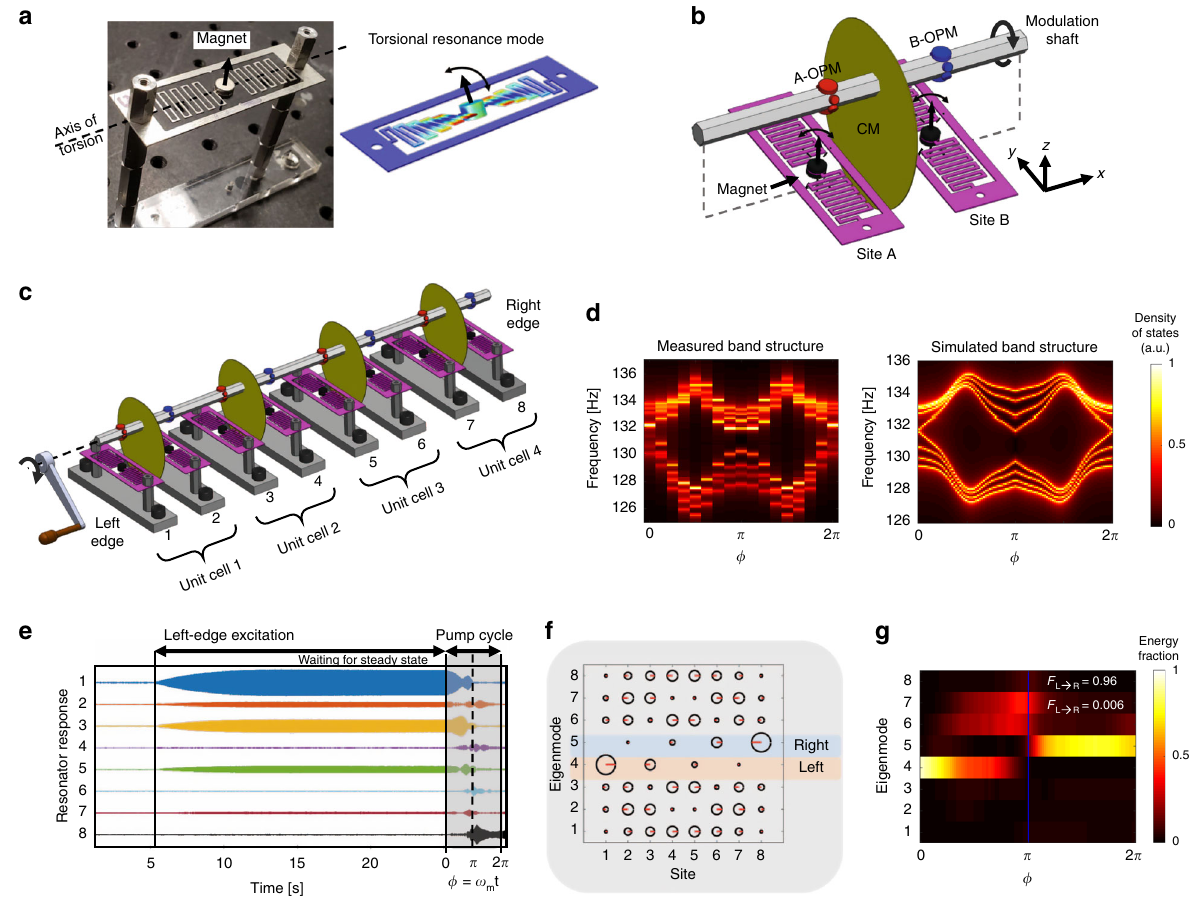
Fig. 2 Magneto-mechanical system description. a Photograph of an individual magnet-loaded mechanical resonator and its simulated torsional resonance mode. b Each unit-cell comprises of two mechanical resonators (Sites A, B) that are coupled through magnetic interaction. Angular rotation ϕ of the modulation shaft (Supplementary Movie 1) simultaneously induces coupling modulation (CM) and on-site potential modulations (OPM). CM is generated with an off-axis high-permeability metal alloy sheet (Supplementary Note 7) while OPM utilizes permanent magnets (Supplementary Note 6). c All experiments use an array of 4 unit-cells. Rotation of the shaft is motorized, though in principle a crank handle (illustrated) could be used to activate the pump. d Band structure is measured quasi-statically by averaging the normalized mechanical impedance spectrum measured at each resonator, for discrete shaft angles ϕ . Experiments and simulations con fi rm edge states at ϕ = 0, 2 π and an open bulk band gap for all ϕ . The simulation includes non-ideal effects such as next-nearest neighbor coupling (Supplementary Note 8). e In a typical pumping experiment, we simultaneously measure the de fl ection of all resonators. The array is driven only at site 1 to primarily excite the left edge mode. After stabilization, the drive is turned off and the pump (shaft rotation) is immediately activated. The example shows a pumping process with rotation rate ω m ≈ 0.3 Hz. f Calculated eigenmodes of the eight resonator array at ϕ = 0. Circle size corresponds to the magnitude of the eigenmode while the red line indicates the corresponding phase (0 to the right, π to the left). The localized topological modes on the left and right edges (modes 4, 5) are highlighted. g Temporal heat map representing the modal energy fractions ( E mode # ) during the pumping process, obtained by projecting the measured motion in e on to the eigenmode basis in f . Mechanical energy is transported from the left edge mode (mode 4) to the right edge mode (mode 5) in one pumping cycle. Fidelity parameter F L → R ≈ 1 (de fi ned in text) indicates successful